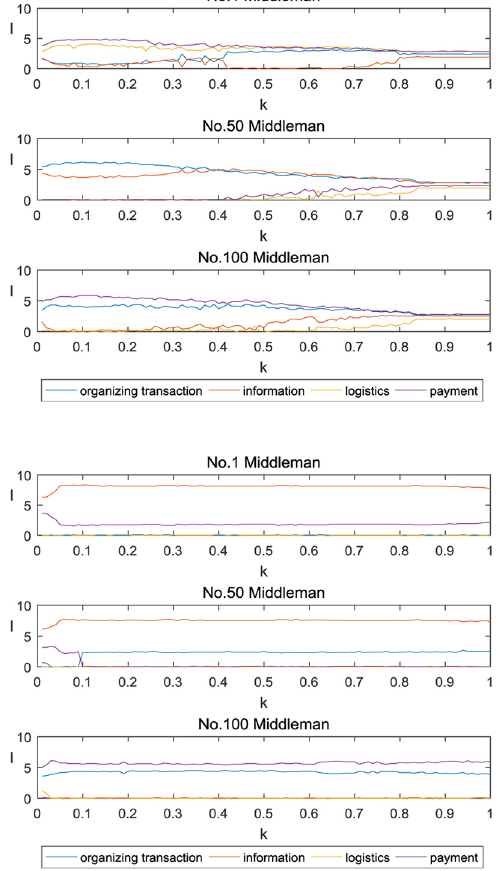
Figure 3. Degree of